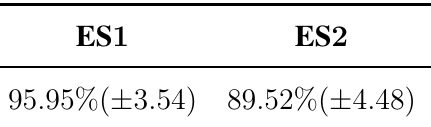
Table 2. The mean test accuracy (and standard deviation) of leaky integrator type of RC network (LI-ESNs) for the two experimental settings (ESs).